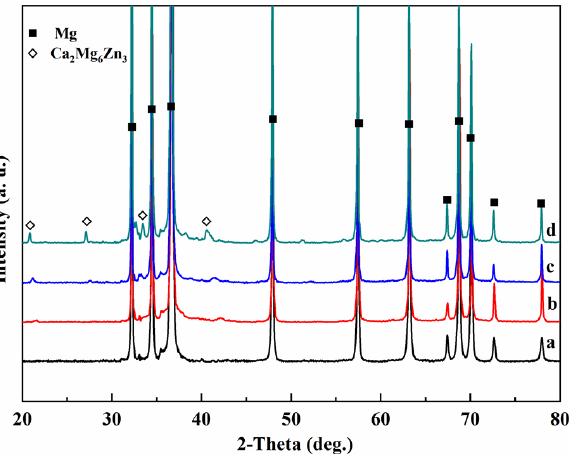
Figure 2. XRD patterns of ZM-xCa alloys: ( a ) ZM-0.1Ca, ( b ) ZM-0.3Ca, ( c ) ZM-0.5Ca and ( d ) ZM-1.0Ca.